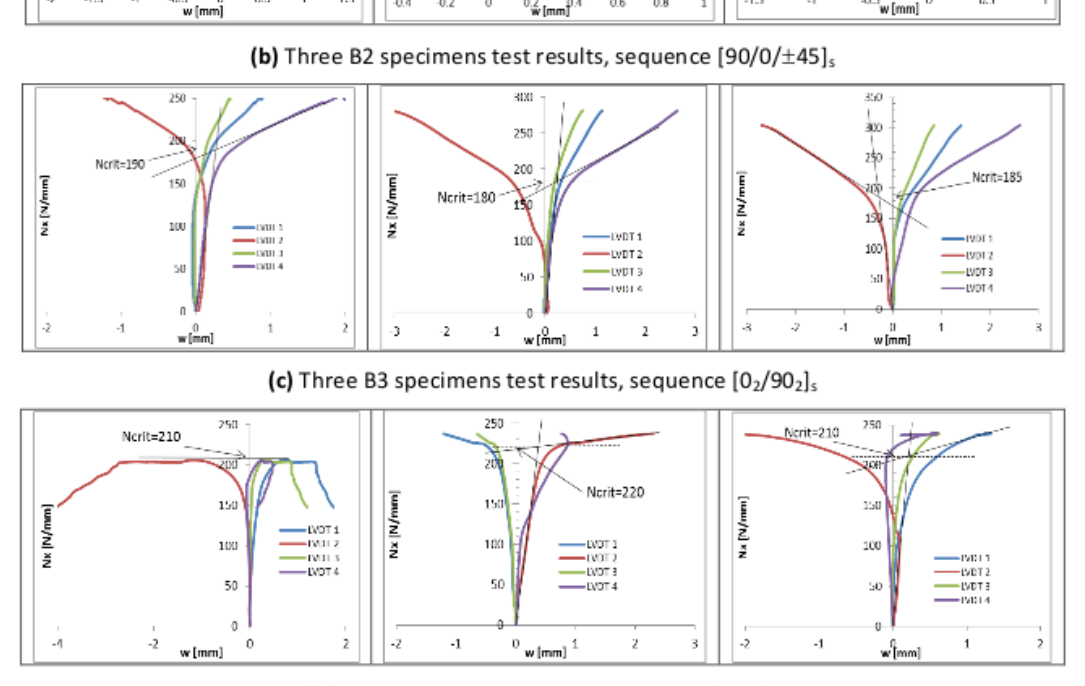
Figure 5: Load (N/mm) versus out-of-plane displacement (mm) for laminated plates (a) B1, (b) B2, (c) B3 and (d) B4